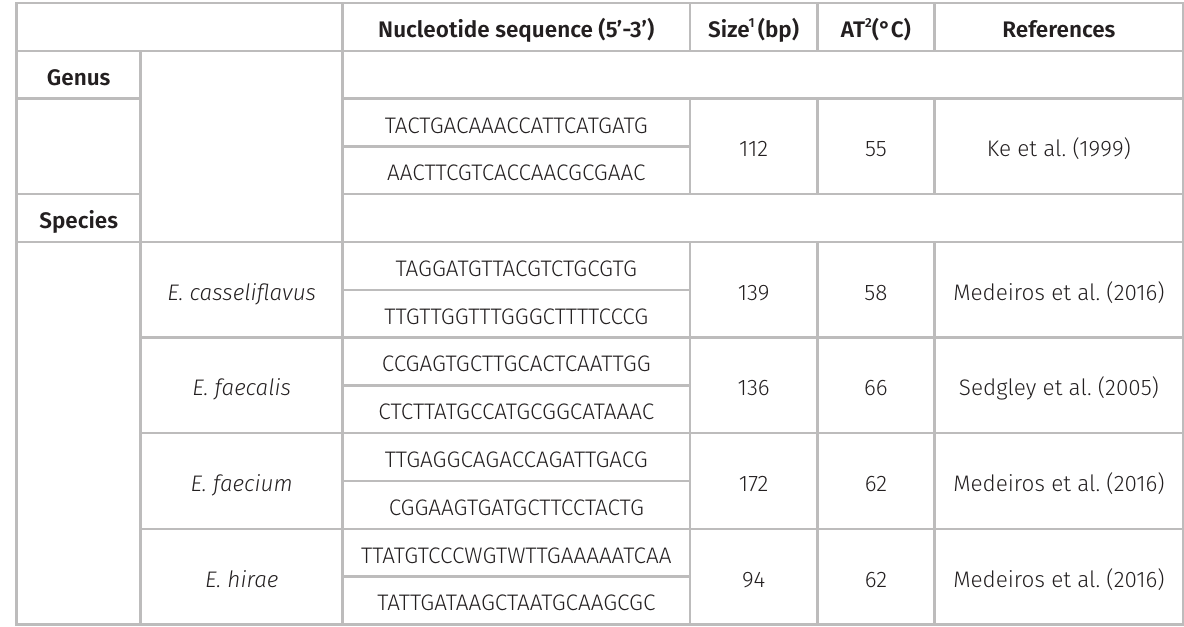
Table I. Primers used in the PCR reactions carried out for identification of enterococci genus and